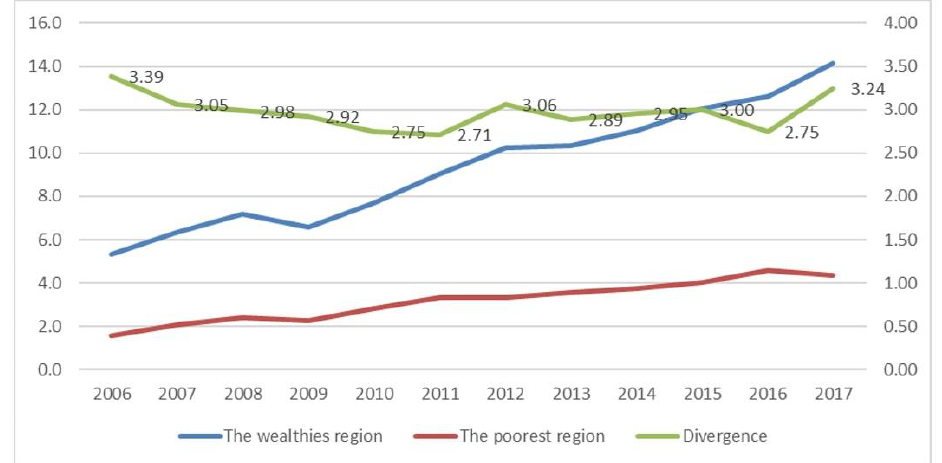
Fig. 1. GDP per capita in the wealthiest and poorest regions of Georgia, and the indicator of divergence for 2006-2017 (Source: own elaboration based on data from the National Statistics Office of Georgia) Table 1. GDP per capita growth rate for the last 5 and 10 years for the regions of Georgia, 2008-2017 (Source: own elaboration based on data from the National Statistics Office of Georgia) Average growth rate for the last Average growth rate for the last Region 10 years [%] 5 years